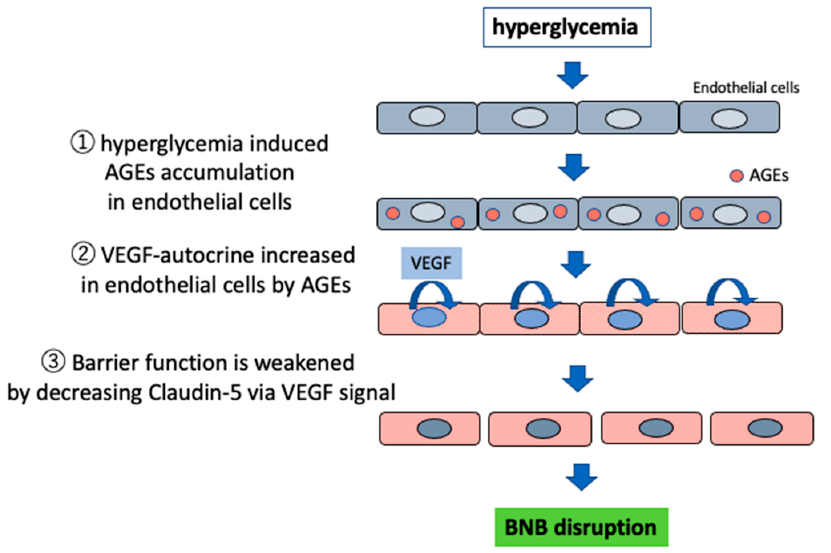
Figure 4. BNB disruption in hyperglycemia by advanced glycation end products (AGEs). Hyperglycemia induced AGE accumulation in endothelial cells. Then, accumulated AGEs increased autocrine VEGF in endothelial cells. Finally, VEGF signal decreased claudin-5 and weakened barrier function.